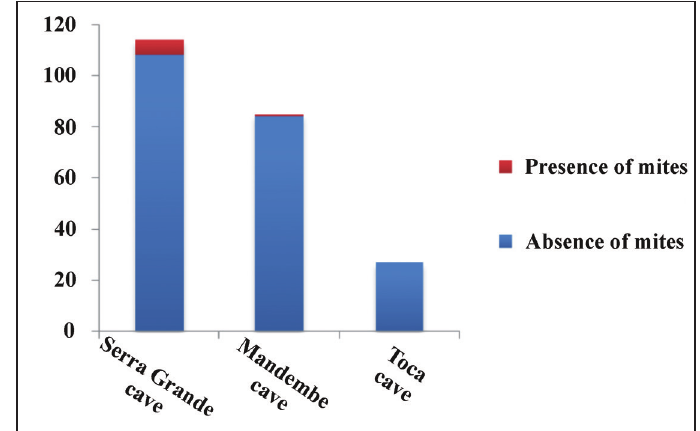
Figure 1. Tanypodinae preying on mites at each studied